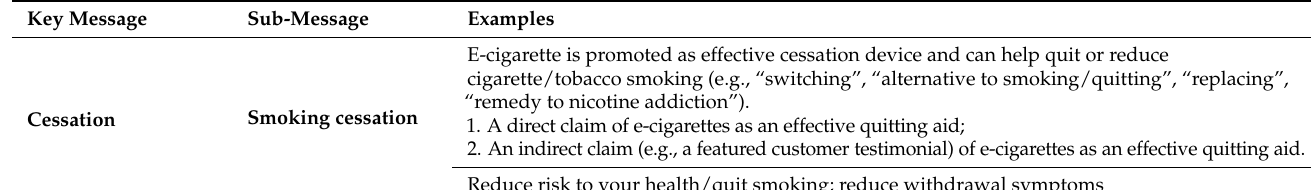
Table A2. Marketing communication messages, sub-messages, and